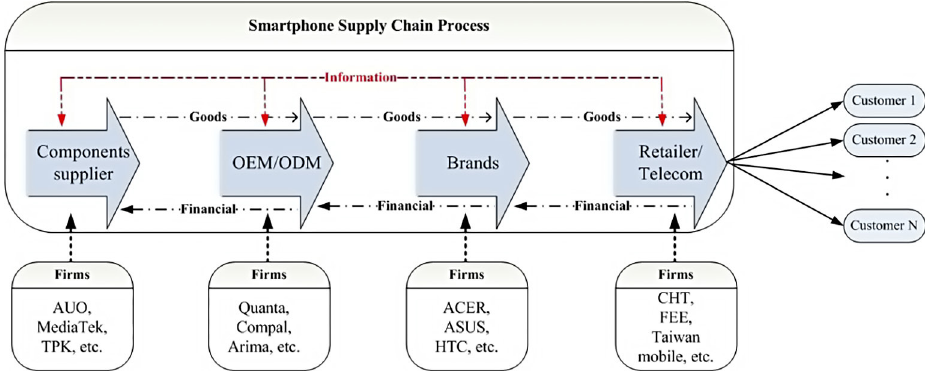
Fig. 3. The Smartphone industry SC process Source : Ali-Yrkko et al . 2011; Linden et al .